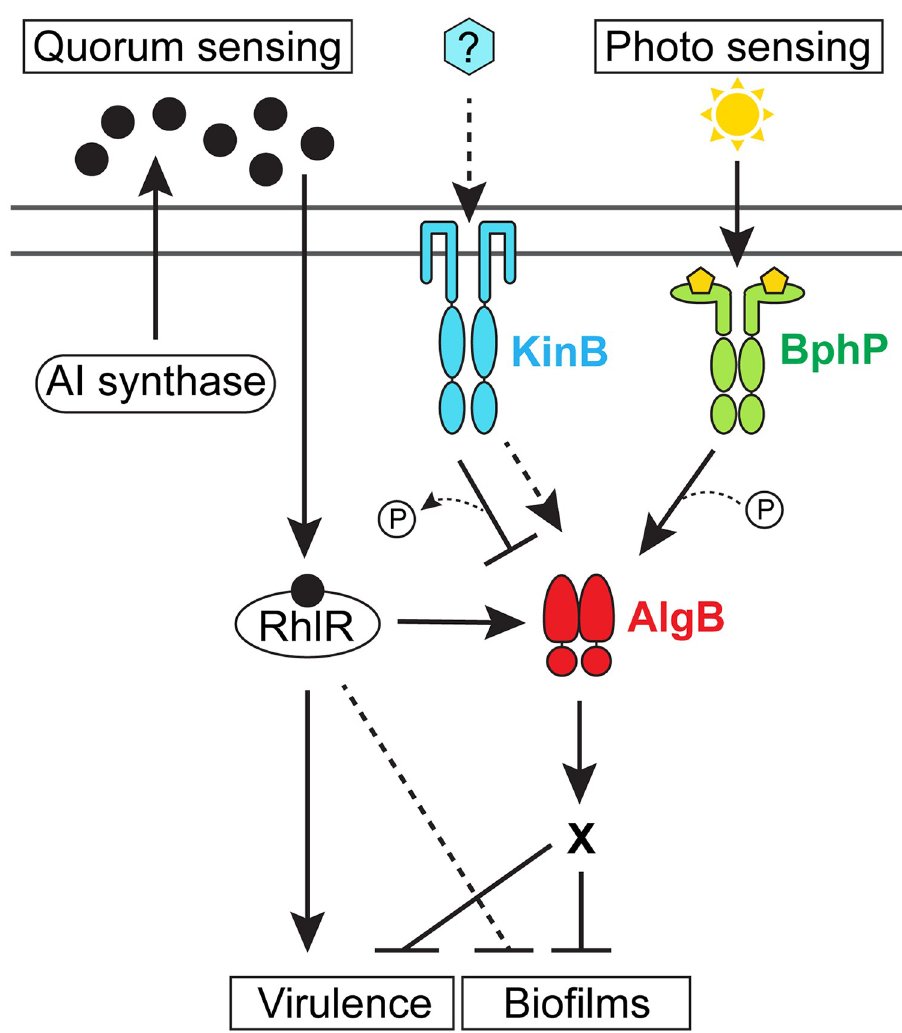
Fig 1. Model for P . aeruginosa integration of quorum-sensing and photosensing information into the control of virulence and biofilm development. The RhlR quorum-sensing receptor binds its partner AI produced by either the RhlI or PqsE autoinducer synthase (black circles) at high cell density [22]. The RhlR–AI complex represses biofilm formation and virulence gene expression by activating transcription of the algB – kinB operon encoding the KinB HK and the AlgB RR, the latter an indirect repressor of biofilm formation. KinB antagonizes AlgB by dephosphorylation. The stimulus (blue hexagon) for KinB is unknown. In the presence of this putative stimulus, the hypothesis is that KinB functions as a kinase for AlgB (dashed arrow). Photosensing stimulates the BphP HK to autophosphorylate and subsequently transfer the phosphoryl group to AlgB to activate AlgB. AlgB-P activates transcription of genes required for repression of group behaviors such as biofilm formation and virulence. A “P” in a circle denotes addition or removal of a phosphate moiety (dotted line). X denotes that the genes functioning downstream of AlgB in the process are not known. The RhlR–AI complex directly activates virulence gene expression and also represses biofilm formation by additional unknown mechanisms (dashed T-bar). AI, autoinducer; HK, histidine kinase; RR, response regulator.